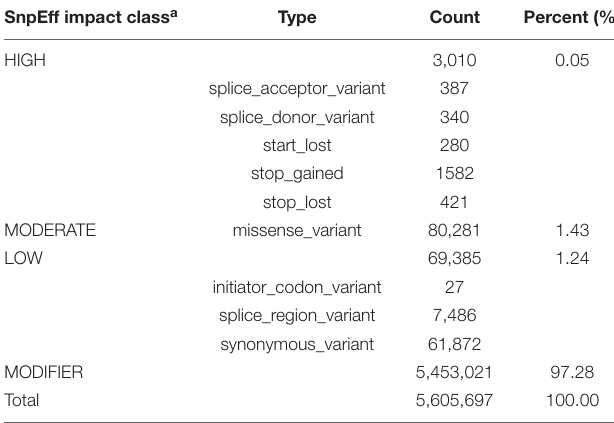
TABLE 5 | Summary of SnpEff functional